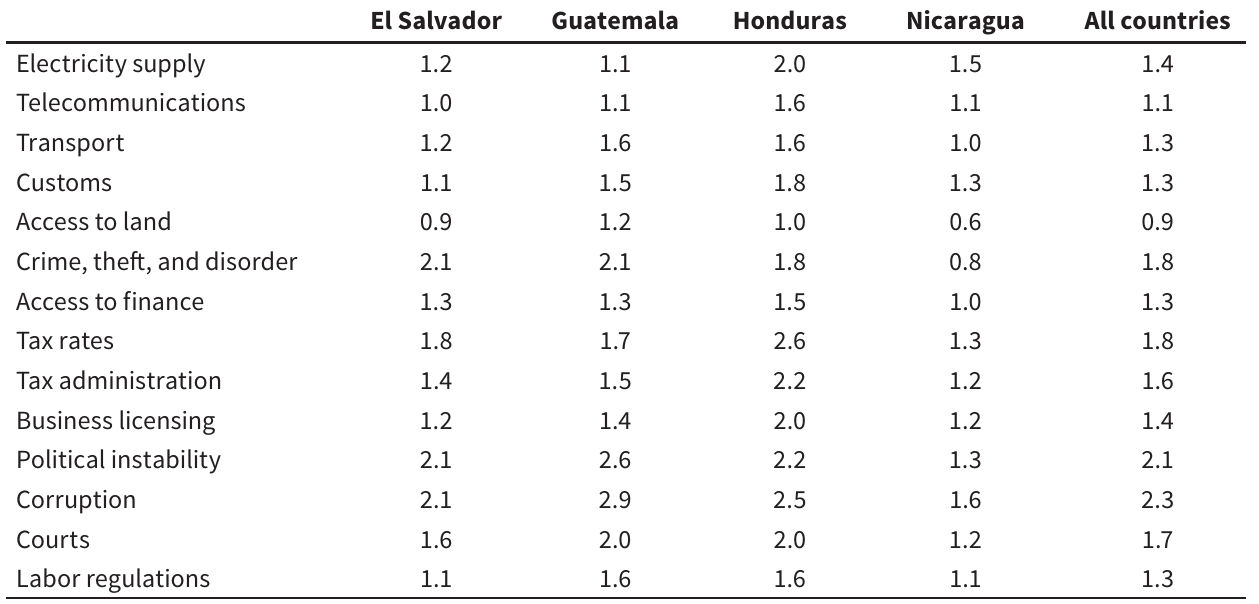
Perceived main obstacles to doing business (average